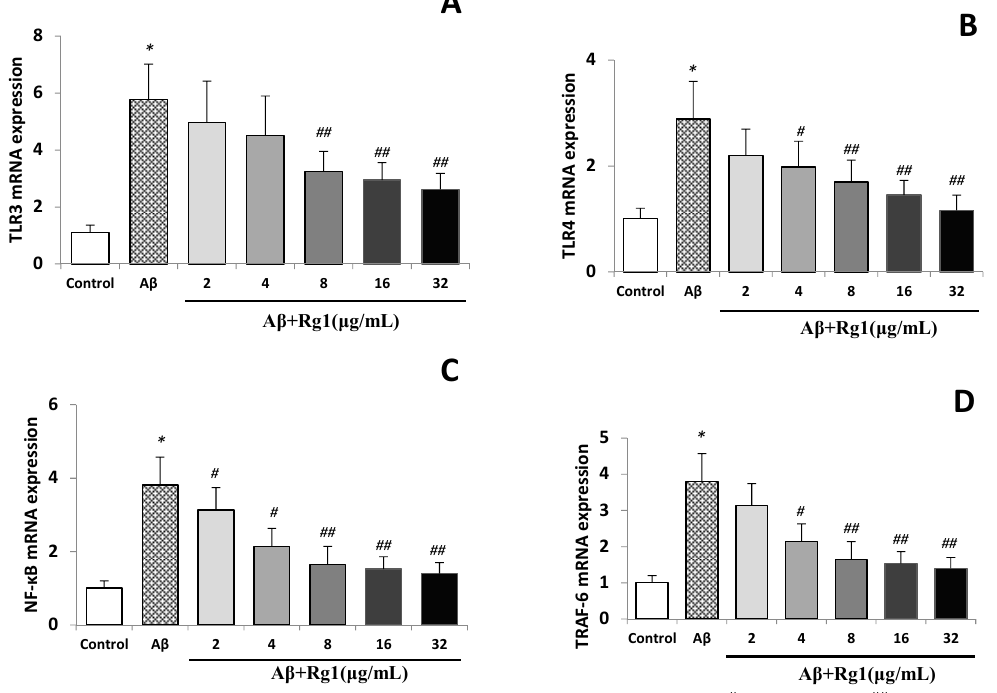
Figure 1. ( A ) Effect of ginsenoside Rg1 on the mRNA levels of TLR3; ( B ) effect of ginsenoside Rg1 on the mRNA levels of TLR4; ( C ) effect of ginsenoside Rg1 on the mRNA Levels of NF- κ B; ( D ) effect of ginsenoside Rg1 on the mRNA levels of TRAF-6.